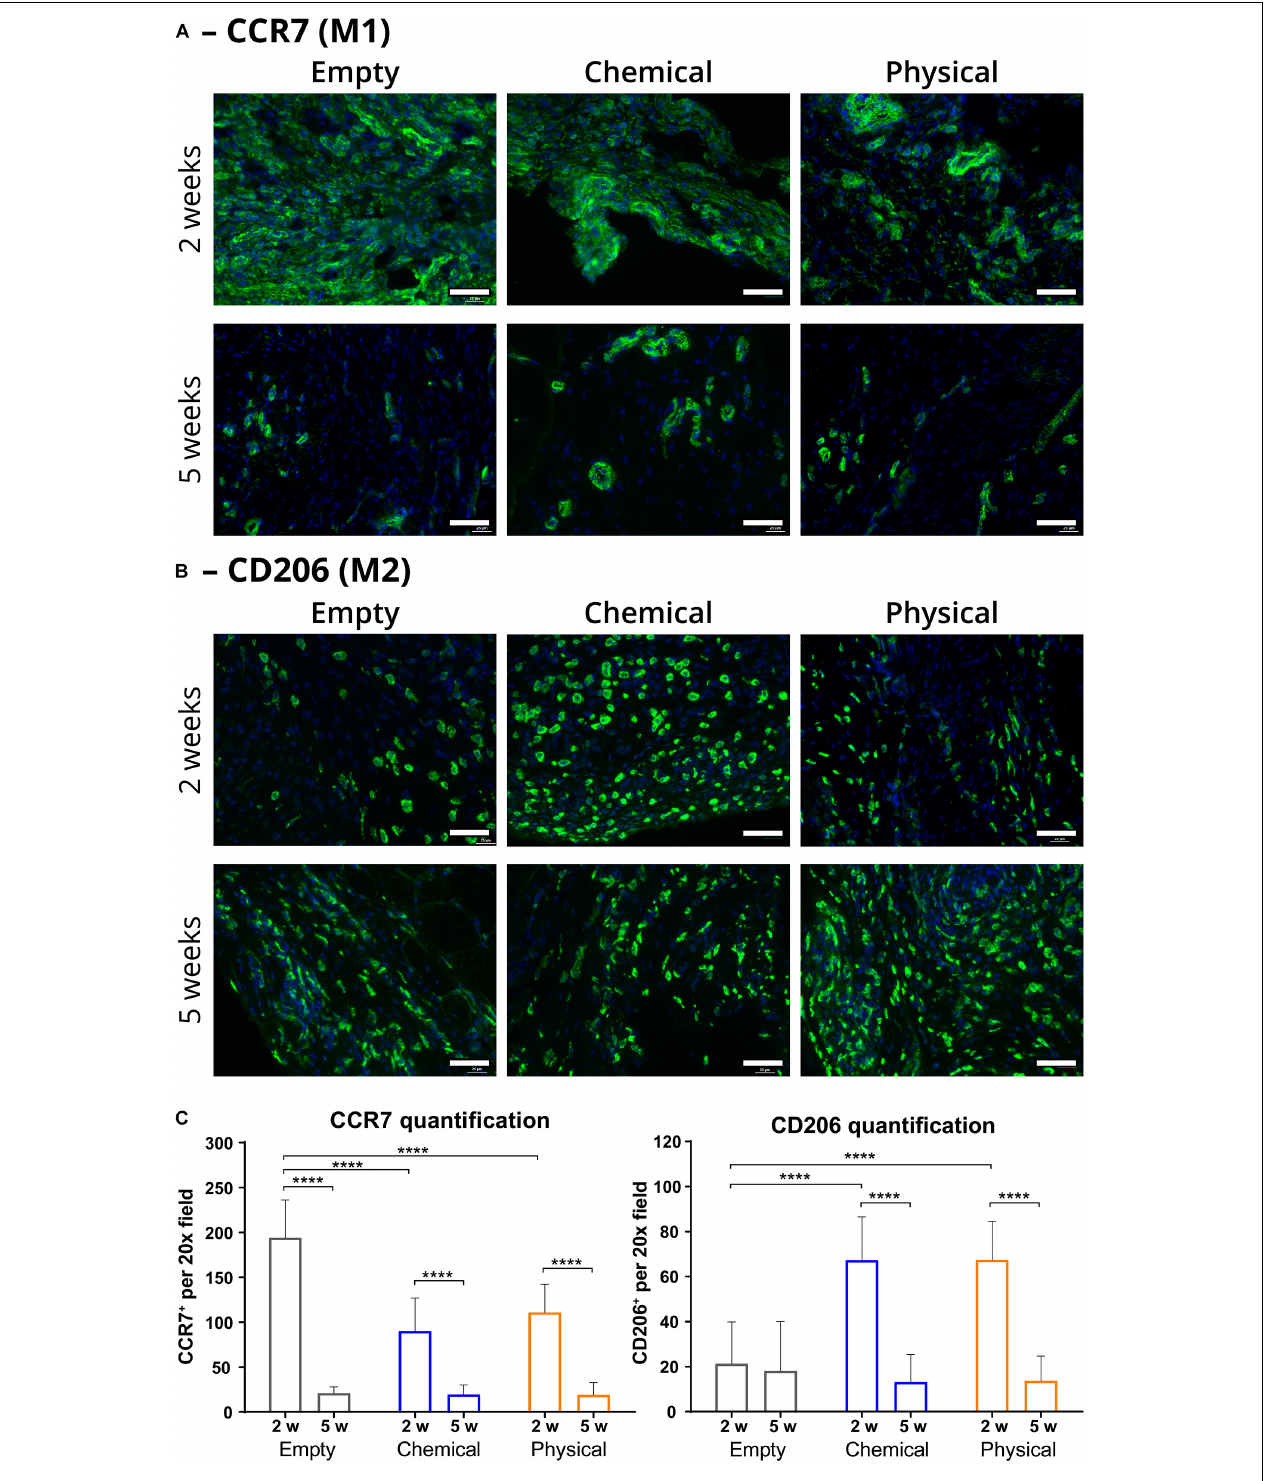
FIGURE 2 | Immunofluorescence representative images and quantification of macrophage populations in the injury area (scaffold and interface regions). (A) Type-1 macrophages (M1 or pro-inflammatory; in green) present in the injury area of samples from the empty (left), chemical (center), and physical (right) groups after 2 (top) and 5 weeks (bottom), labeled with an anti-CCR7 antibody. (B) Type-2 macrophages (M2 or anti-inflammatory; in green) present in the injury area of samples from the empty (left), chemical (center), and physical (right) groups after 2 (top) and 5 weeks (bottom), labeled with an anti-CD206 antibody. (C) Quantification of macrophage populations in the injury area (number of CCR7- or CD206-positive cells per 20 × field) at 2 (2 w) and 5 weeks (5 w) post-injury. All the samples were counterstained with DAPI for nuclei. Scale bar = 50 µ m. n = at least 16, which are the number of 20 × fields used for the quantification. **** p < 0.0001.